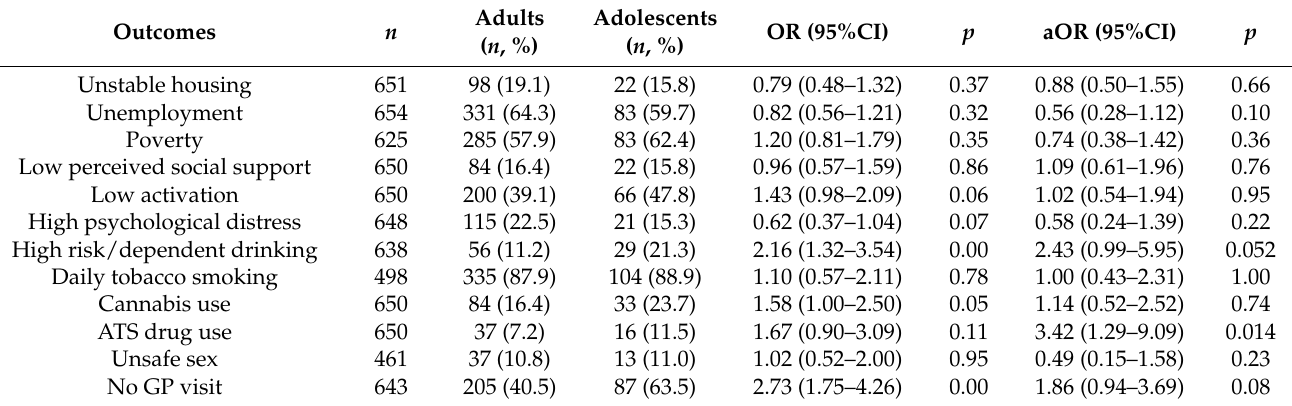
Table 3. Associations between age and key outcomes at 6-month